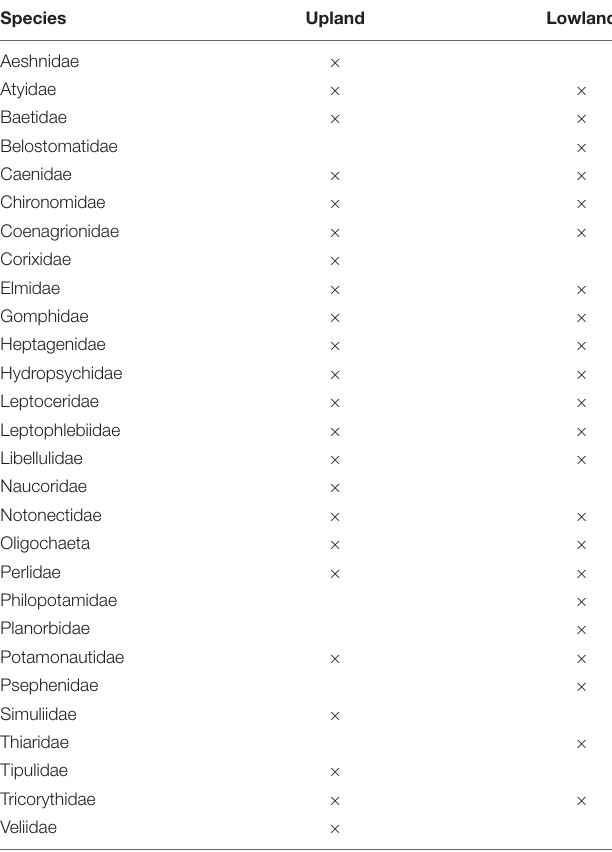
TABLE 3 | Macroinvertebrate taxa contributing to within-group similarity in the upland (27.13%) and lowland (24.05%) rivers of KwaZulu-Natal, South Africa, between 2015 and